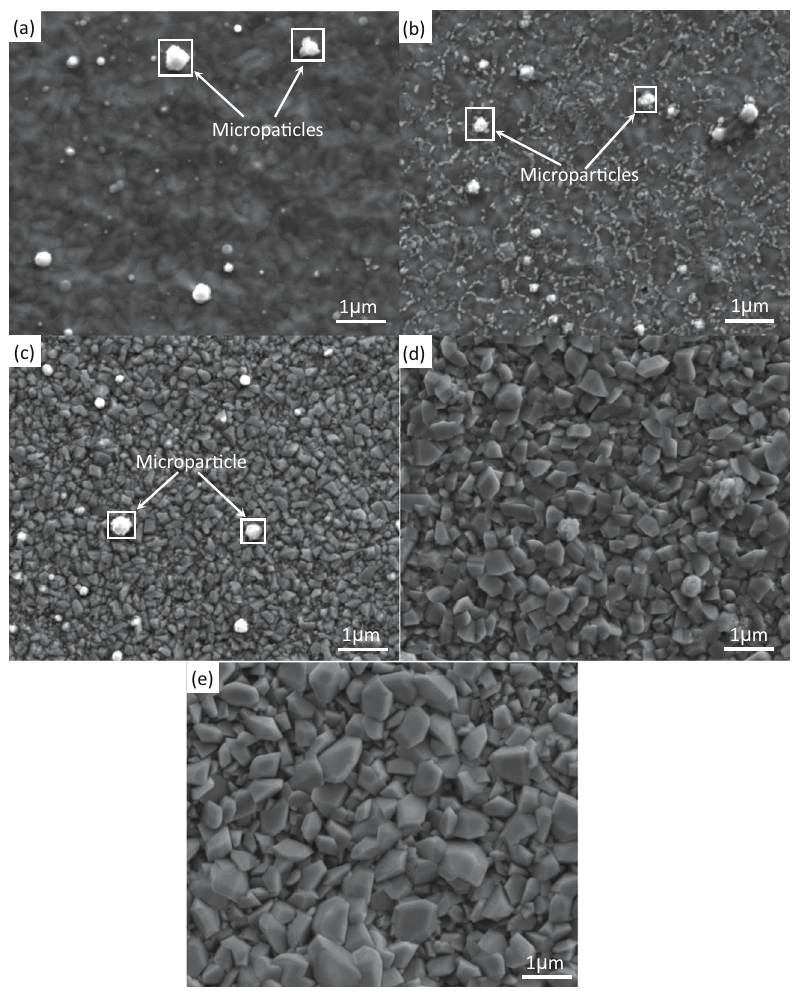
Figure 8: SEM surface micrograph of CrN coating A: ( a ) as deposited, ( b ) oxidized at 500°C, ( c ) oxidized at 600°C, ( d ) oxidized at 700°C and ( e ) oxidized at ( Figure 9c ) results in the generation of hexagonal O crystals with a size of 40 – 80 nm. chromium oxide Cr 2 3